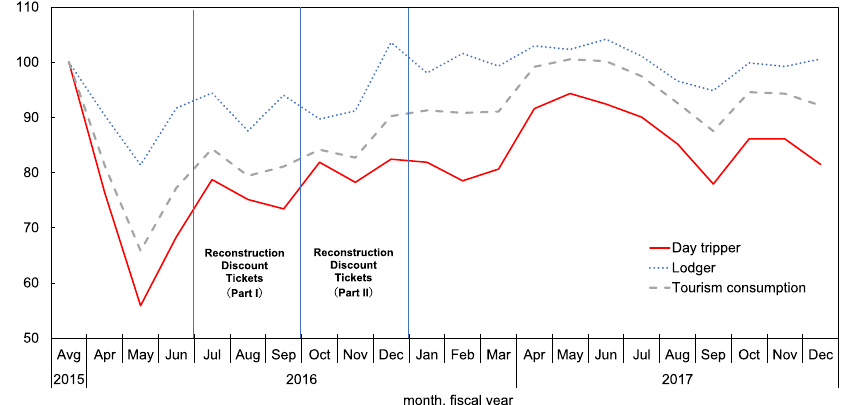
Fig. 3 Index of tourists and tourism consumption. Source: Based on the Kumamoto Tourism Statistics, Kumamoto Prefecture. Average in FY2015 100. Seasonally adjusted. Tourism consumption is the number of = tourists multiplied by per capita